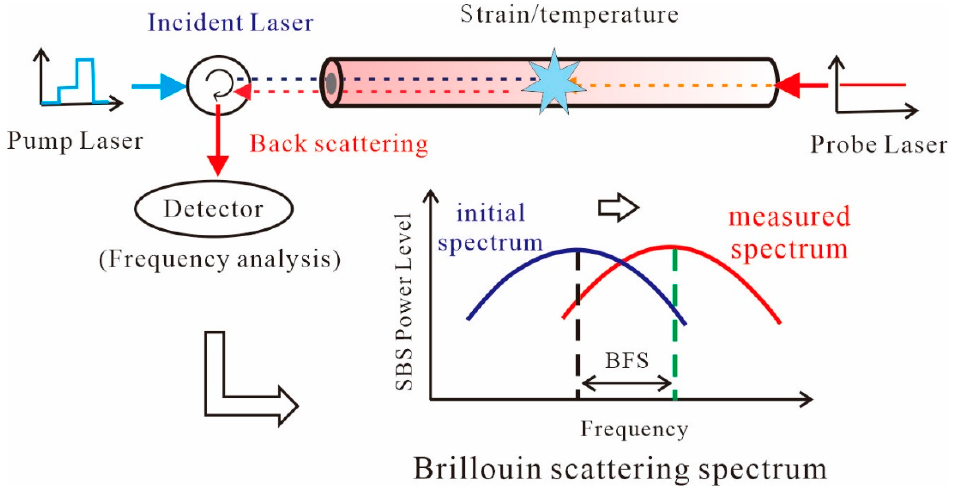
Figure 1. Principle of BOTDA (modified from Zhao [33]).